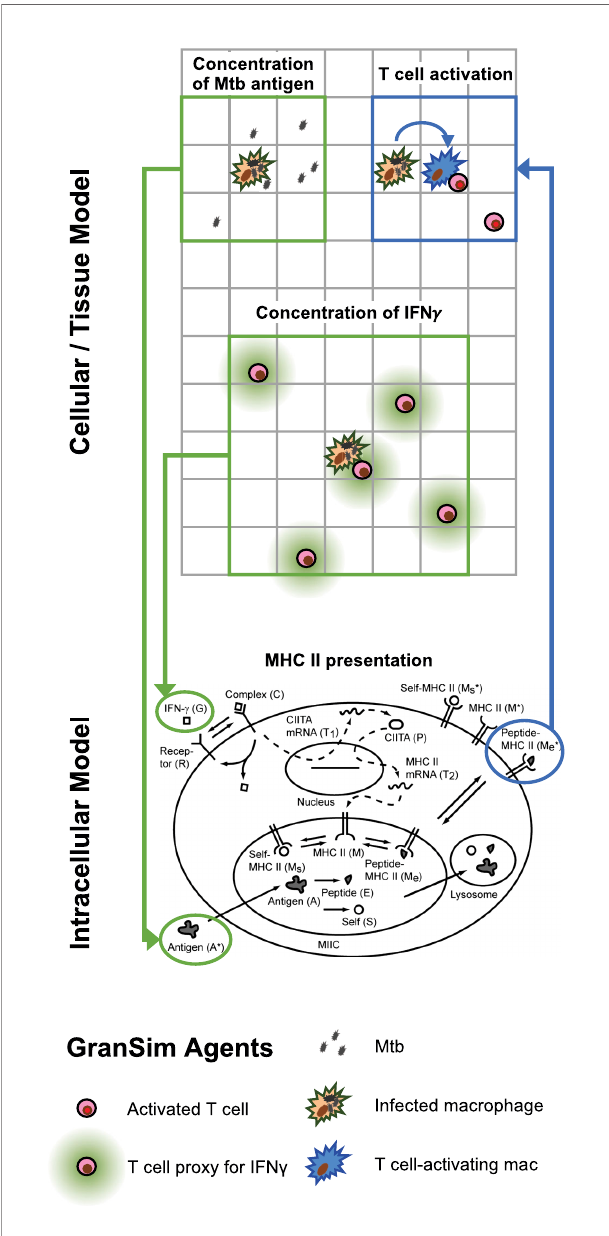
FIGURE 2 | Multi-scale model schematic showing the integration of the intracellular scale model into the mesoscale cellular/tissue model. Within our combined multi-scale model, the cellular/tissue scale is modeled with GranSim , an agent-based model capturing dynamics of immune cells, effector molecules and mycobacteria within lungs leading to formation of granulomas. Full cellular and molecule dynamics are not shown for GranSim , only the places where the intracellular model links with GranSim . For the intracellular model, 14 non-linear ordinary differential equations (ODEs) are represented by this schematic for 14 variables (published previously and listed in Table S1 for reference here). GranSim linking is accomplished via inputs to ODEs (green arrows) including the concentration offree IFN- g (calculated based on T cell numbers) and concentration offree Mtb antigen (calculated using the number of Mtb in a macrophage ’ s one Moore neighborhood). The ODE output of MHCII-Mtb complexes on a macrophage surface is linked back into GranSim (blue arrow). Once these macrophages reach a threshold of surface MHCII-Mtb complexes, they are able to activate T cells within their